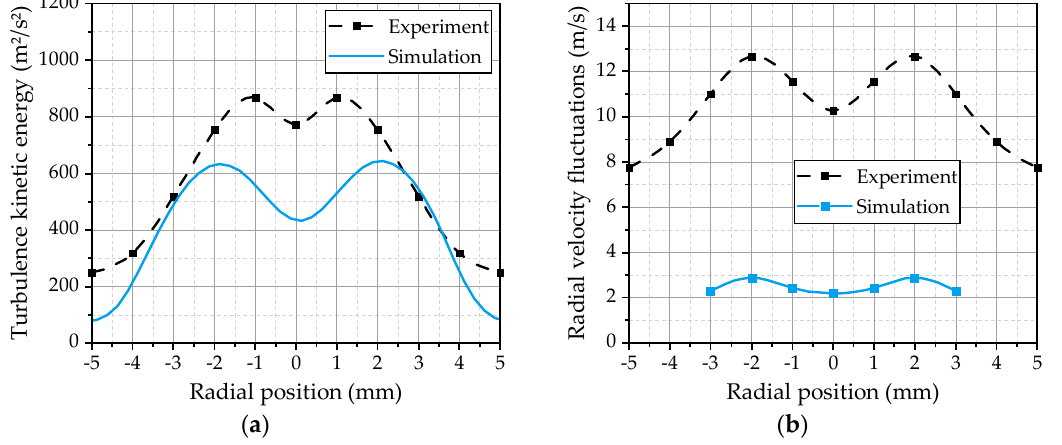
Figure 11. ( a ) Simulated and measured radial profiles of the turbulence kinetic energy calculated from the fluctuations of the corresponding velocity components of the droplets for the experiment and from the gas phase turbulence for the simulation. ( b ) Radial velocity fluctuations calculated from the fluctuations of the corresponding velocity components of the droplets for both the simulation and experiment.